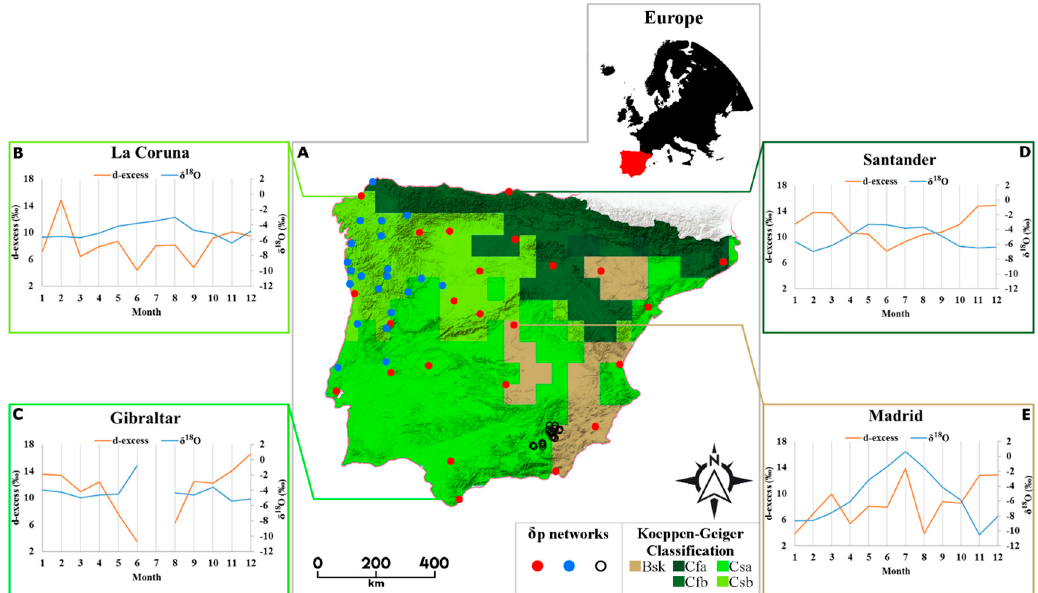
Figure 1. The Iberian Peninsula, with precipitation stable isotope measurement networks and Köppen climate zones [34]. The 24 stations of the Global Network of Isotopes in Precipitation (GNIP) network [23] functioning between October 2002–October 2007 (red solid circles), and two regional networks (NW: [35]; and SE: [36]) are marked with blue solid circles and black circles, respectively ( A ). The seasonal cycle of δ 18 O p and d-excess of precipitation of the four characteristic climate zones ( B , C , D , E ) was computed for mean monthly data of a common six-yr-long (2001–2006) reference period. The color coded Köppen climate zones [34] overlaid on the World_Terrain_Base basemap (Sources: Esri, USGS, NOAA) in ArcMap 10.5 [37]. The red area on the Europe inset map shows the Iberian Peninsula.